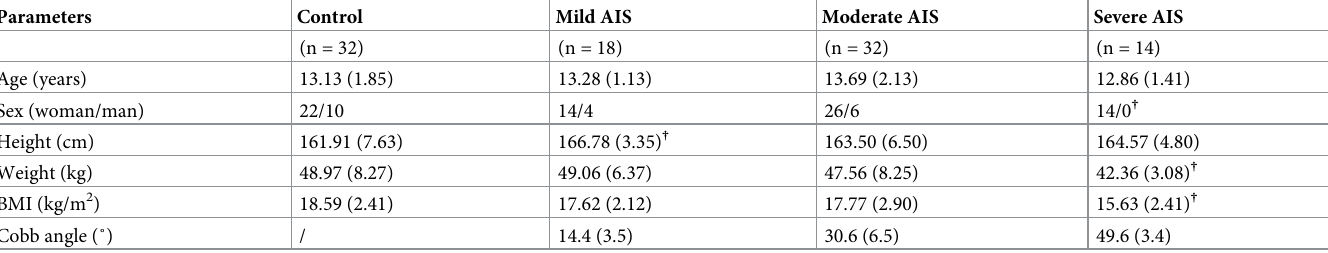
Table 1. Characteristics of the participants with mild, moderate, and severe AIS as compared with those of the controls. Parameters